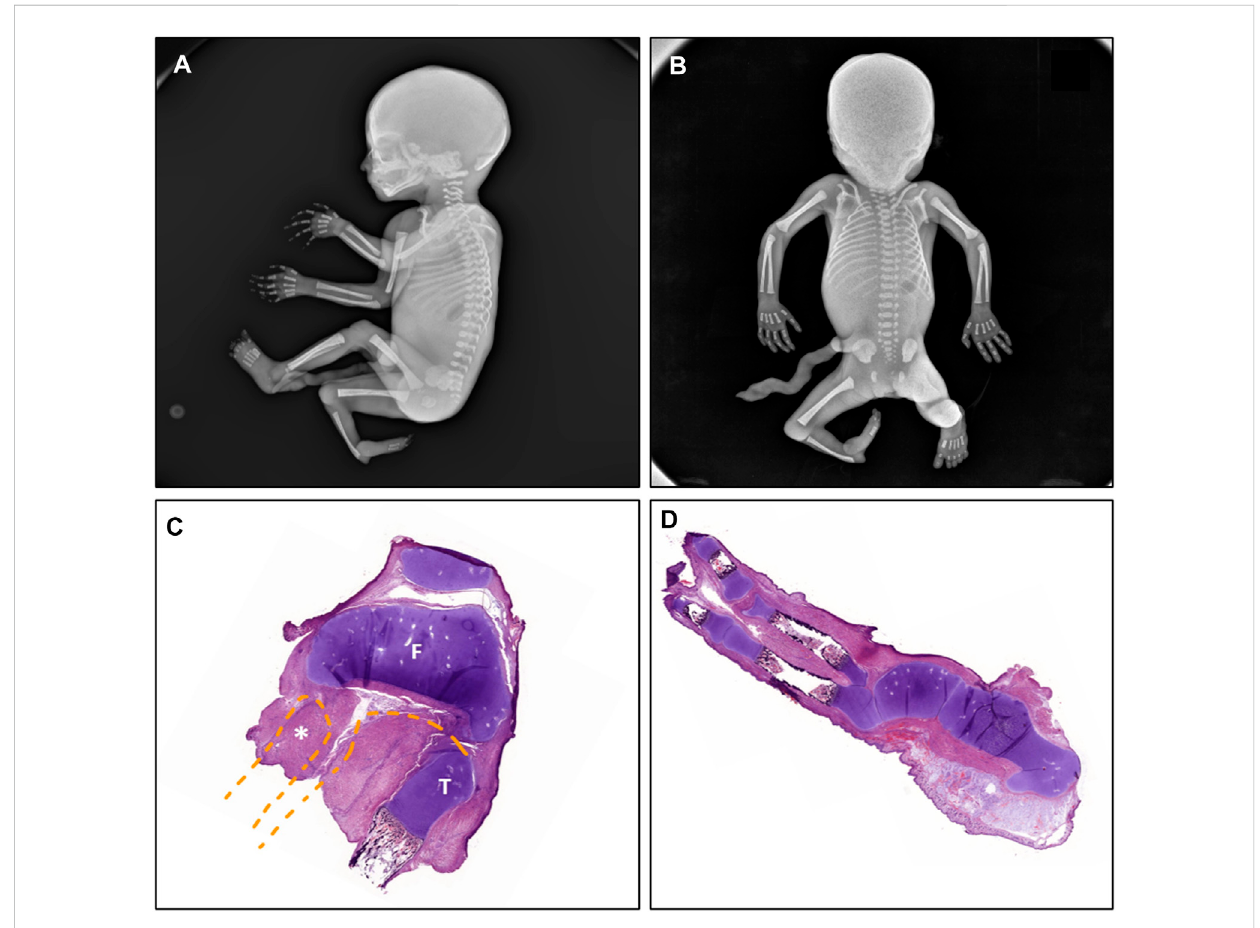
FIGURE 1 Radio-histopathologicalmanifestationsobservedinthefetuscompatiblewithFACTOsyndrome.Theradiologicstudyshowedthepresenceofarightlower limb malformation with absence of long distal bone ( (A) , lateral view) with aplasia of multiple metatarsal and tarsal foot bones, absence of the ankle joint and malrotationoftherightfoot( (B) ,posteriorview).Thehistopathologicalstudiesrevealed (C) completeabsenceoftheright fi bula,partialproximaltibialhypoplasia with the presence of (D) vestigial tarsal bones, partial absence of metatarsal bones and oligodactyly (split foot malformation). F: femur; T: tibia; *: fi